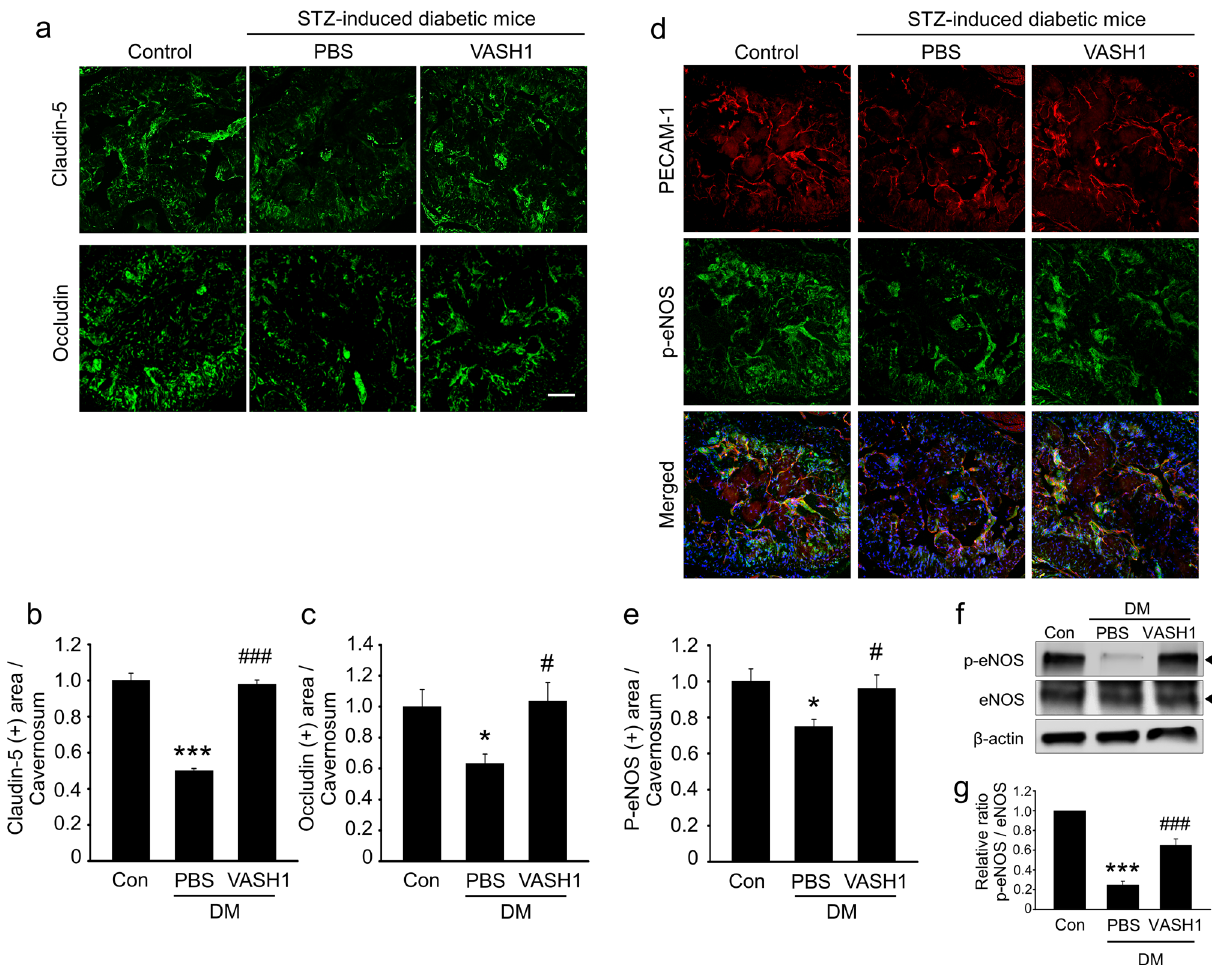
Figure 5. VASH1 protein transfer restores cavernous endothelial cell–cell junction proteins and induces eNOS phosphorylation in diabetic mice. ( a ) Occludin (green) and claudin-5 (green) staining in cavernous tissue from age-matched control and streptozotocin-induced diabetic mice 2 weeks after receiving repeated intracavernous injections of PBS (days − 3 and 0) or VASH1 protein (days − 3 and 0; 4 μg/20 μL). Scale bar = 100 µm. ( b , c ) Occludin and claudin-5-immunopositive areas were quantified by Image J. Each bar depicts the mean (± SE) values from N = 6 animals per group. * P < 0.05, *** P < 0.001 vs. control group. # P < 0.05, ### P < 0.001 vs. PBS- treated DM group. ( d ) Phospho-eNOS (p-eNOS, green) and PECAM-1 (red) staining in cavernous tissue from each group of mice. (e) P-eNOS-immunopositive areas were quantified by Image J. Each bar depicts the mean (± SE) values from N = 6 animals per group. * P < 0.05 vs. control group. # P < 0.05 vs. PBS-treated DM group. ( f ) Representative Western blots for phospho-eNOS and eNOS in each group of mice. ( g ) Relative ratio of phospho- eNOS compared with that of eNOS. Each bar depicts the mean (± SE) values from N = 4 animals per group. *** P < 0.001 vs. control group. ### P < 0.001 vs. PBS-treated DM group. DM diabetes mellitus. Full length blot as well as the related images available in the supplementary